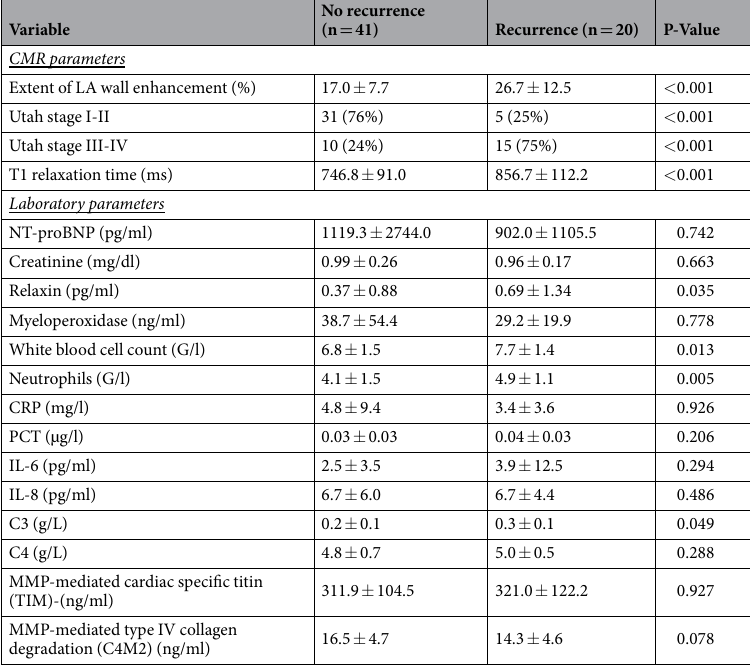
Table 2. Laboratory parameters and CMR parameters in patients with and without recurrence of atrial fibrillation after ablation therapy. Data are mean ± standard deviation or absolute frequency with percentages in parentheses. LA = left atrial; MMP = matrix metalloproteinase; CMR = cardiac magnetic resonance.